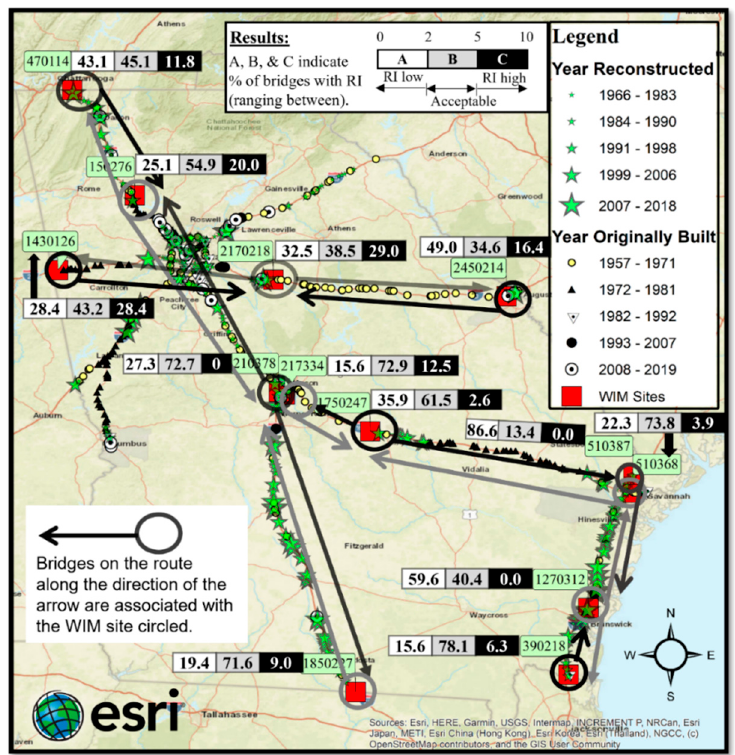
Figure 4. Map showing locations of old and reconstructed bridges in Georgia.